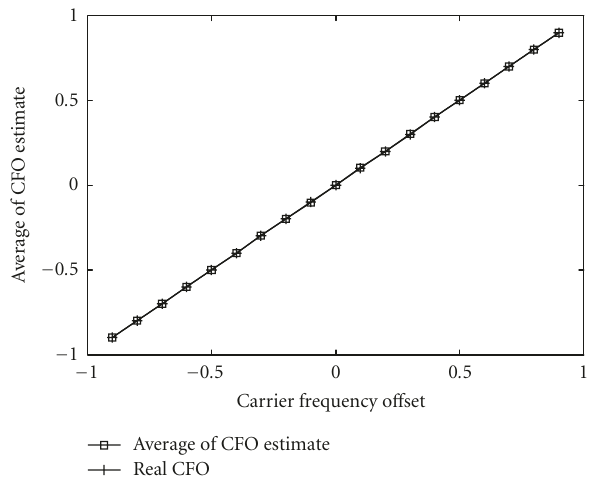
Figure 4: MSE comparison of CFO estimation algorithms with light I/Q imbalance ( g = 0 . 1 dB and θ = 5 ◦